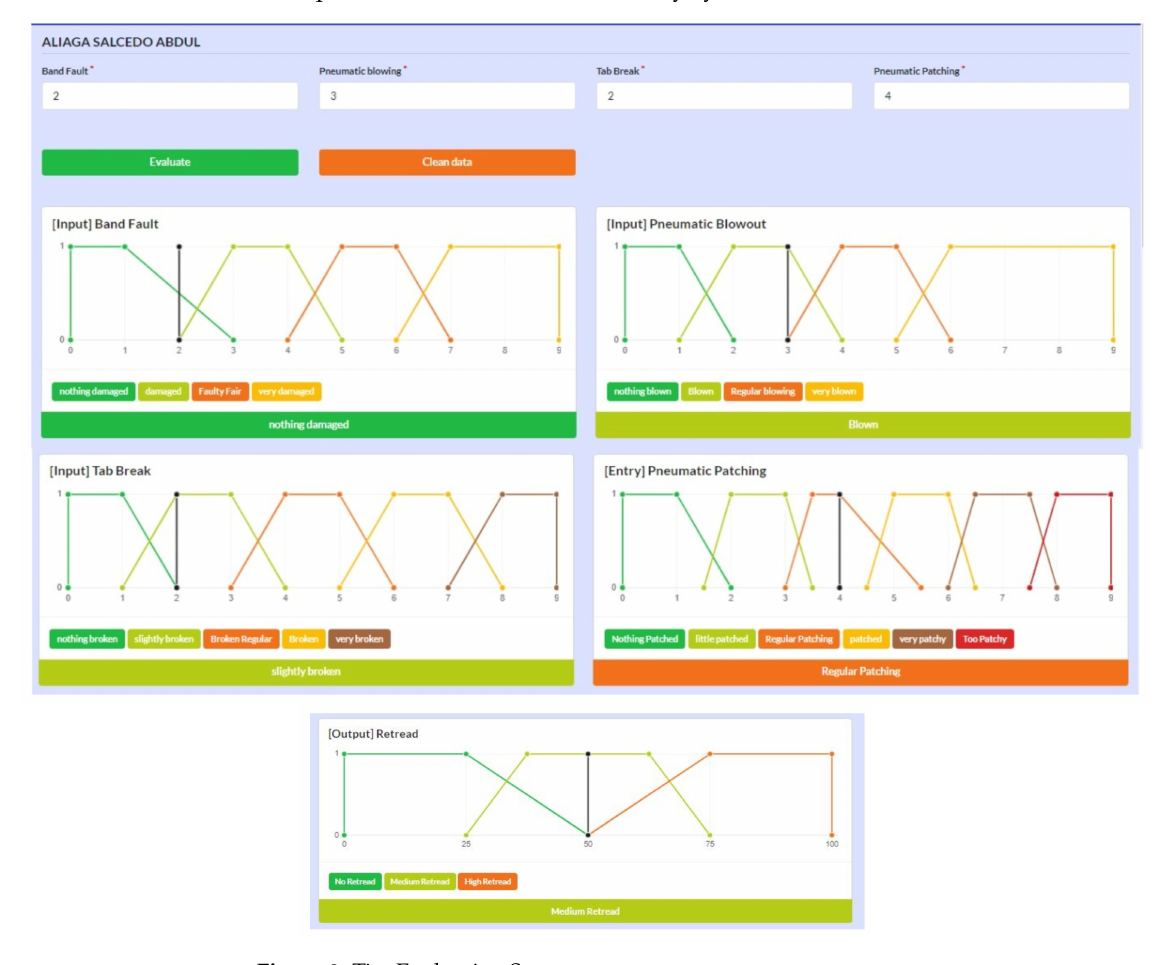
Figure 9. Tire Evaluation Screen. Table 4. Example of a test scenario for the fuzzy